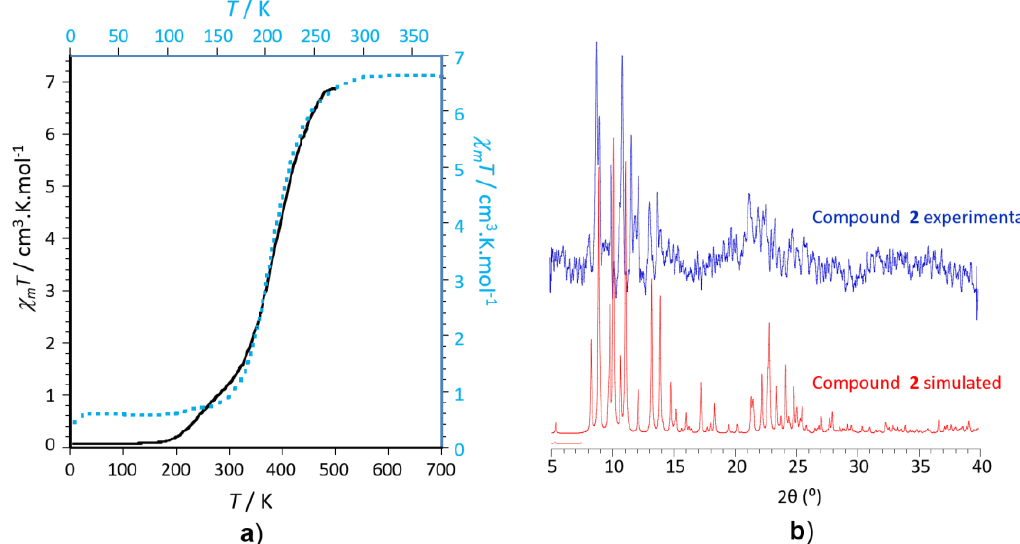
Figure 6. ( a ) Temperature dependences of the χ m T product of 1 (black solid line) and 2 (blue dashed line) showing similar behaviours above 320 K, when the transition temperatures are not taken into account; ( b ) observed and calculated X-ray powder diffraction patterns for compound 2 .